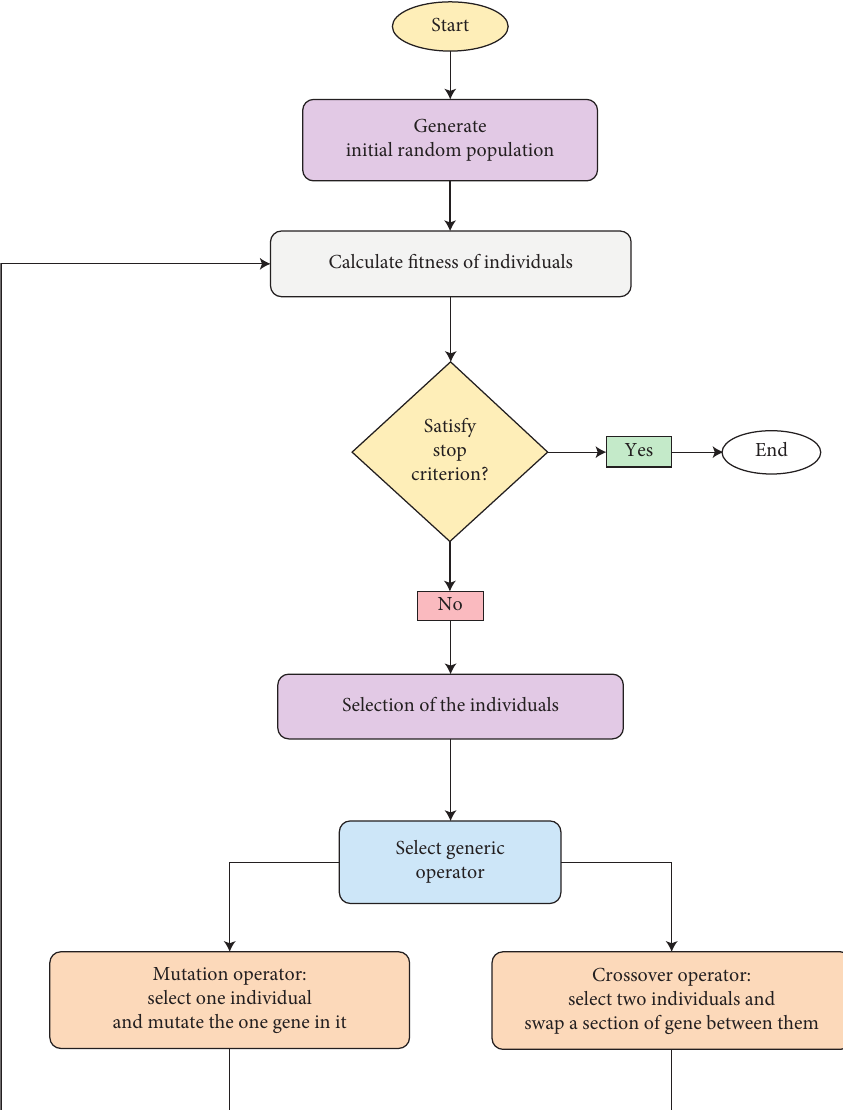
Figure 1: Flowchart of genetic algorithm